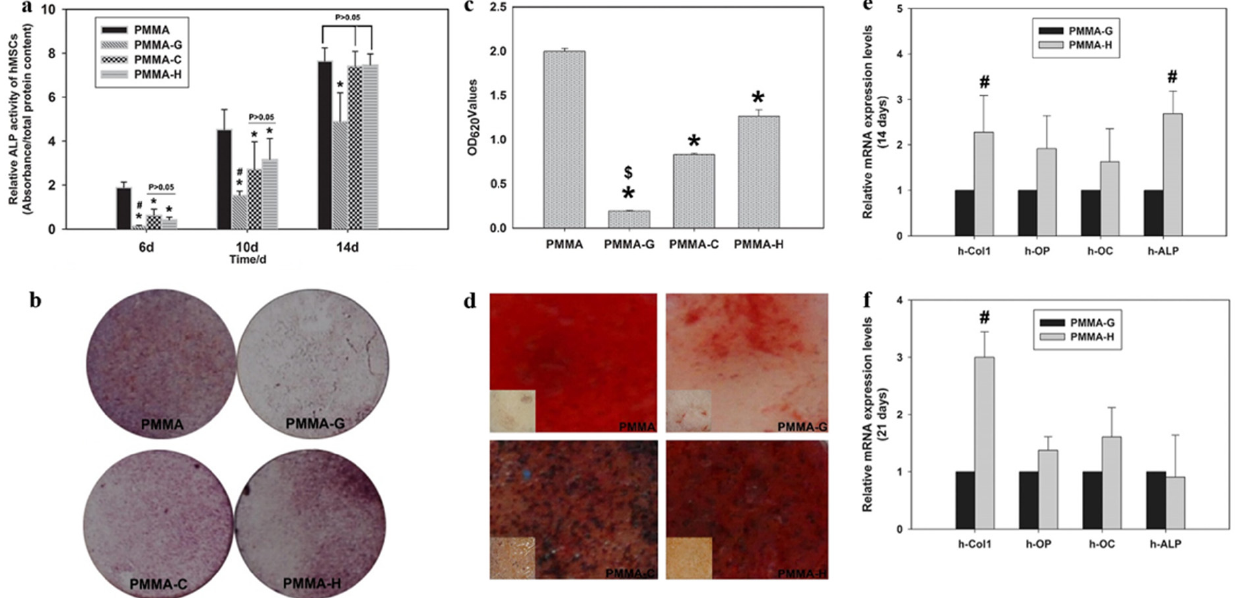
Figure 8. ( a ) Relative ALP activity of hMSCs after 6, 10, and 14 days of culture, (*) denotes a signif- icantly lower ALP activity of cells than that on the PMMA surface at day 6 and day 10 ( p < 0.01), (#) denotes a significantly lower ALP activity level compared to that on the PMMA-C and PMMA-H at day 6 and day 10 ( p < 0.05); ( b ) Image of the positive ALP staining on the four PMMA-based bone cements on day 14; ( c ) Colorimetric quantitative analysis of the extracellular matrix mineralization on the samples after three weeks of incubation, (*) denotes significantly lower mineralization than the mineralization on the PMMA ( p < 0.01). ($) denotes significantly lower mineralization than the mineralization on PMMA-H ( p < 0.01); ( d ) Alizarin Red staining showing that mineralization was consistent with the quantitative analysis of mineralization; ( e , f ) Relative osteogenesis-related gene expressions of the hMSCs cultured on the PMMA-G and PMMA-H bone cement for 14 days and 21 days based on real-time PCR, # p < 0.05 compared with PMMA-G. Data were redrawn from